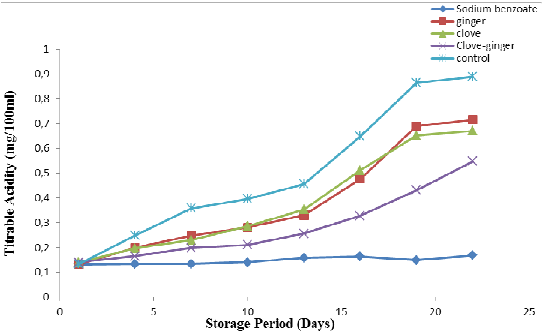
Fig. 18. Effects of various treatments on the titrable acidity of soymilk samples at 5% concentration stored at refrigerated temperature for 25